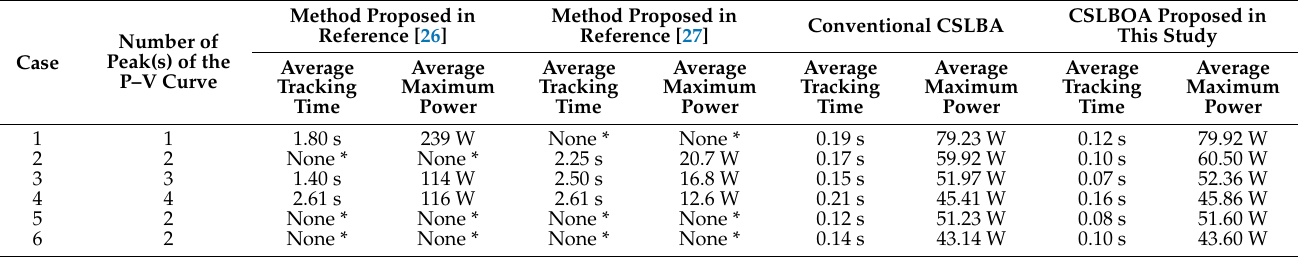
Table 7. Comparison of simulation tests results for the six selected